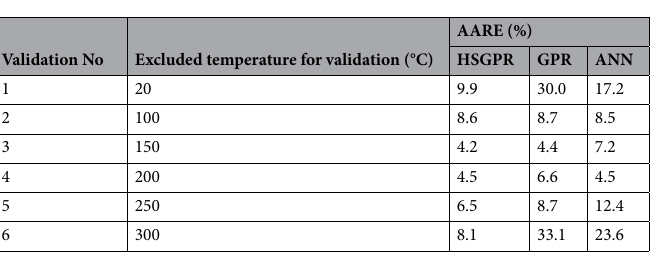
Table 4. AARE of ANN-based flow stress model, HSGPR-based flow stress model, GPR-based flow stress model on cross validation set.